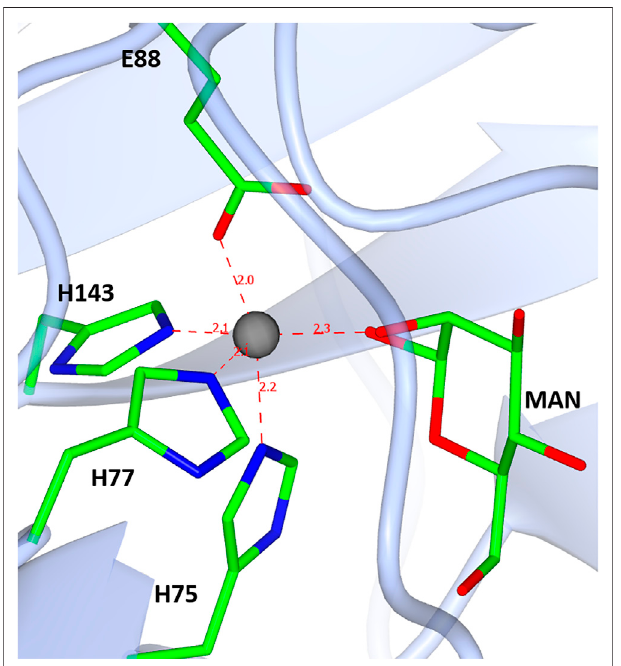
FIGURE 11 | A diagram showing the D-mannose sugar bound in the active site of TsLI with the manganese ion (shown in red) co-ordinated to the three histidines H75, H77 and H143, one glutamic acid E88, and the manganese ion.